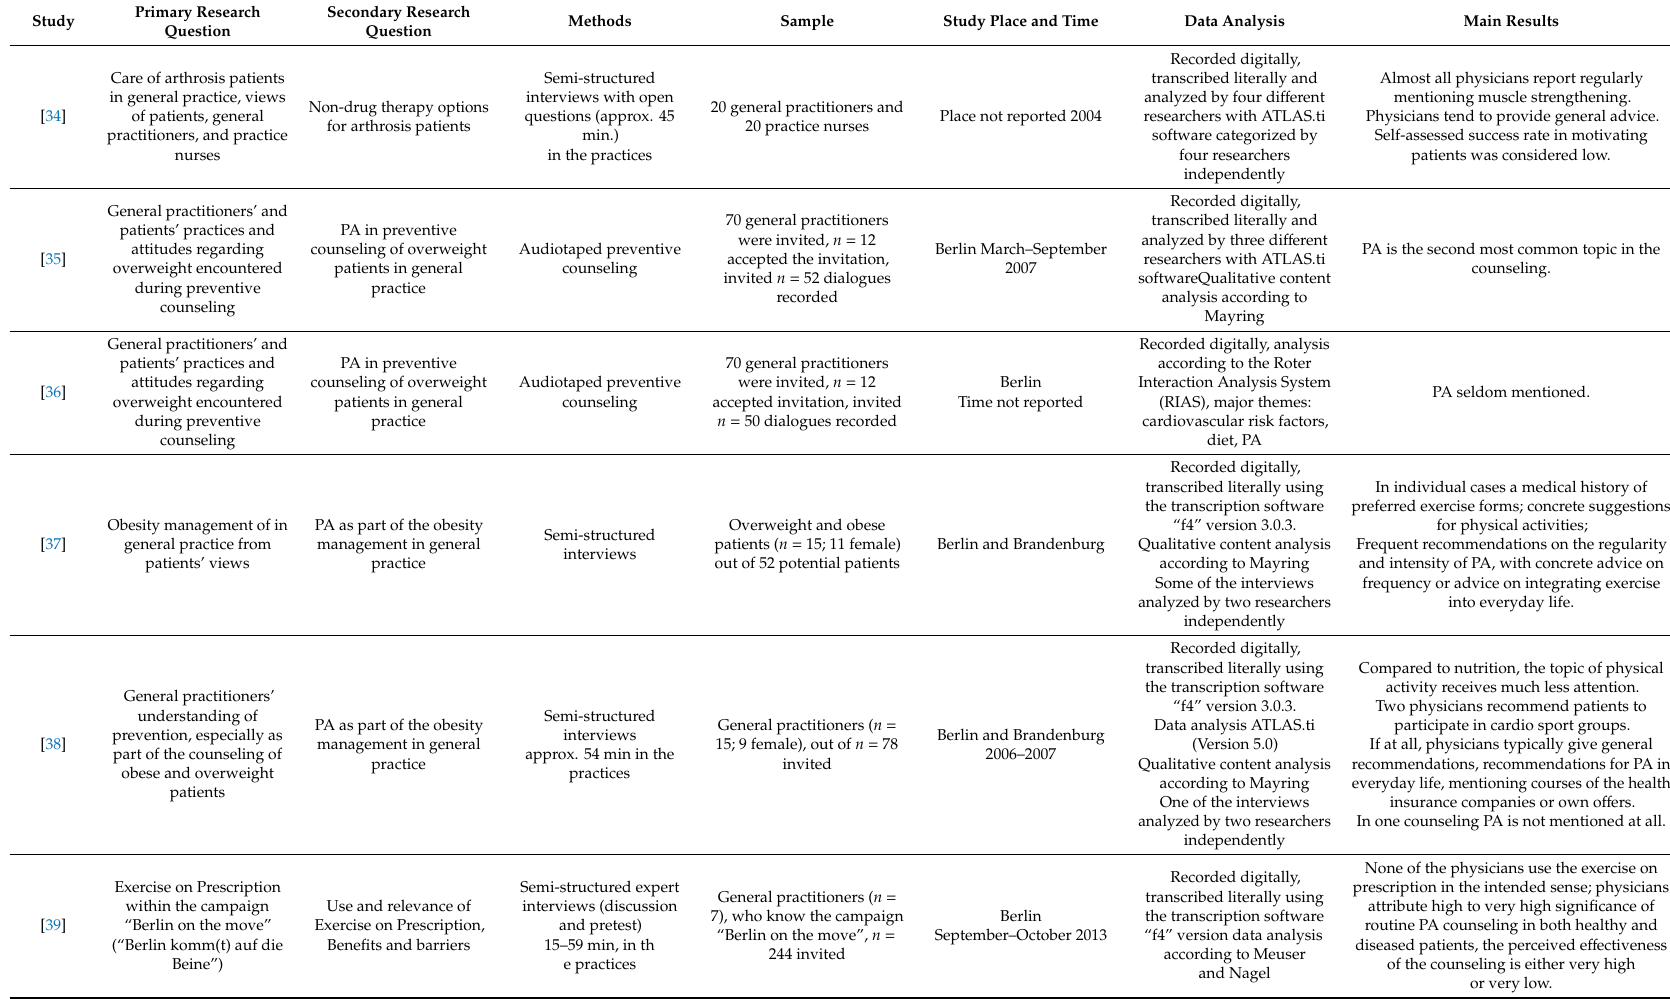
Table 2. Qualitative